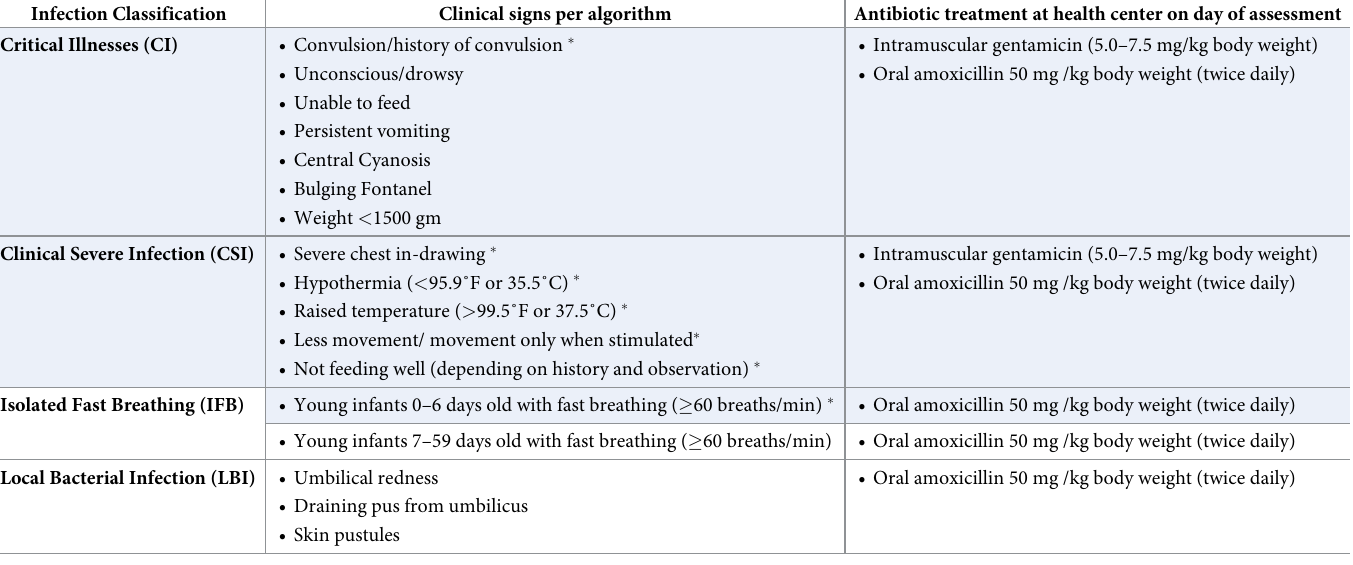
Table 1. Infection classification according to the clinical algorithm and antibiotic treatment on the day of assessment. Infection Classification Clinical signs per